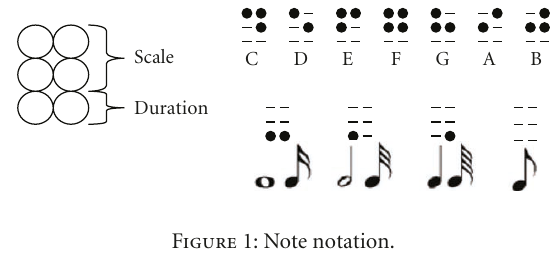
Figure 1: Note notation.